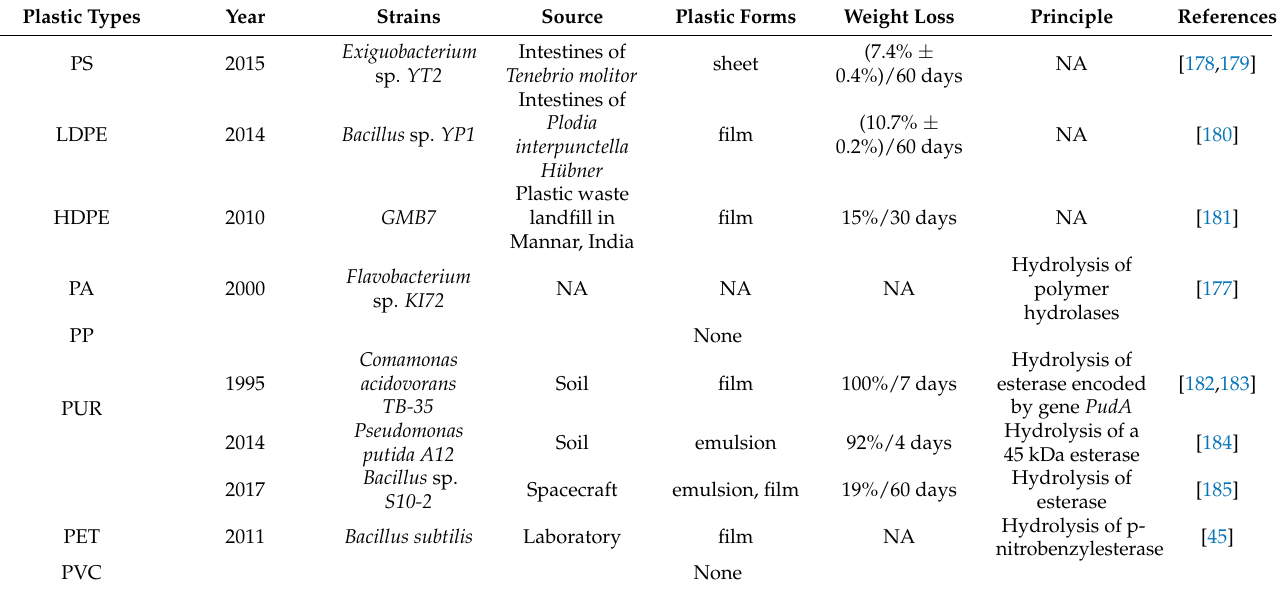
Table 3. Outstanding plastic-degrading bacteria in existing